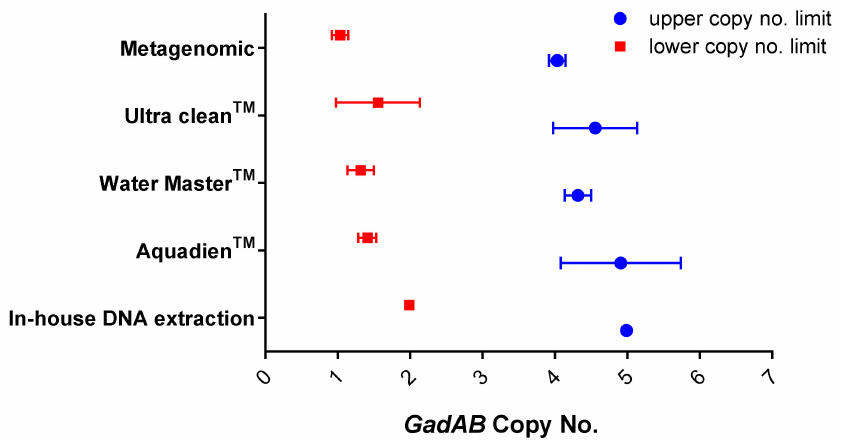
Figure 4. Comparing the in-house DNA extraction method and commercial DNA extraction water- testing kits upper and lower copy number